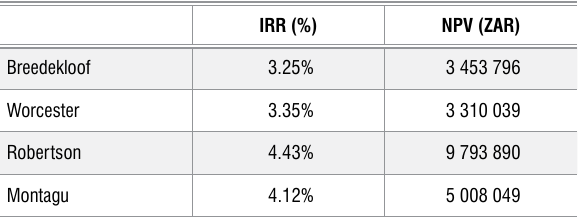
table 5: The expected internal rate of return on capital investment (IRR) and net present value (NPV) for the ‘typical farm’ of each area irr (%) npV (ZAr) Breedekloof 3.25% Worcester Robertson Montagu